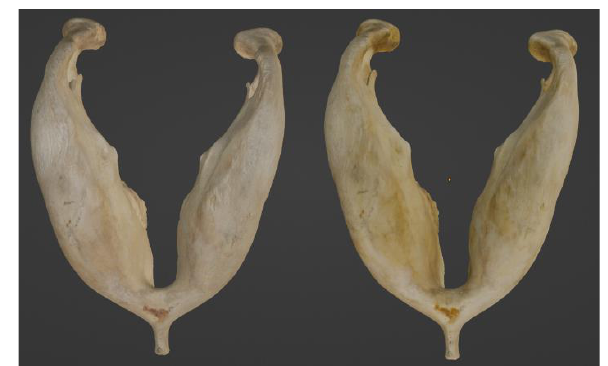
Figure 10. Colour calibrated models of the hand held 3D scanner (left) and SfM